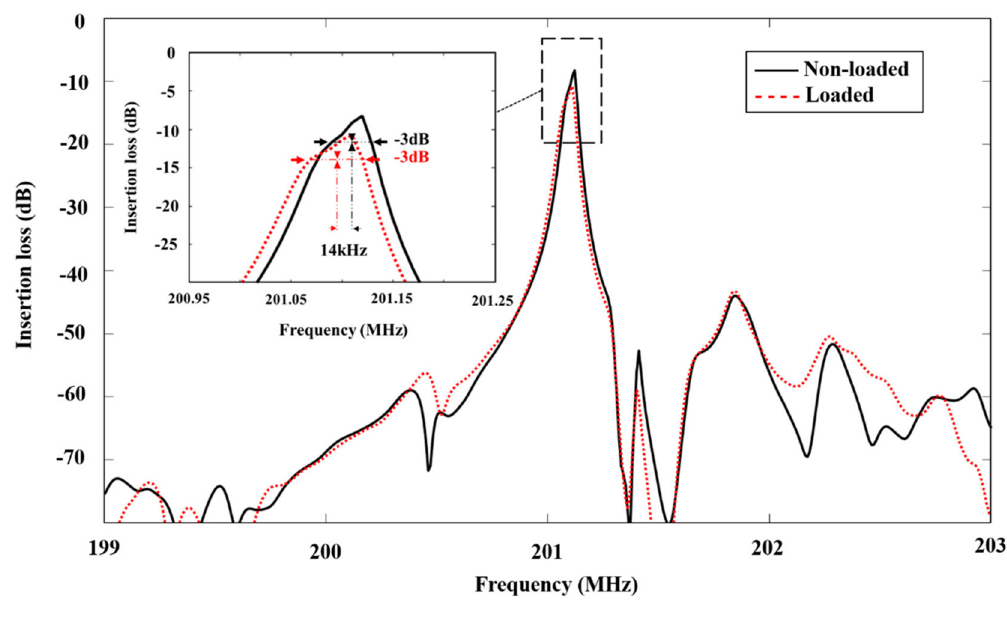
Figure 9. Simulation result of the frequency response before and after loading.